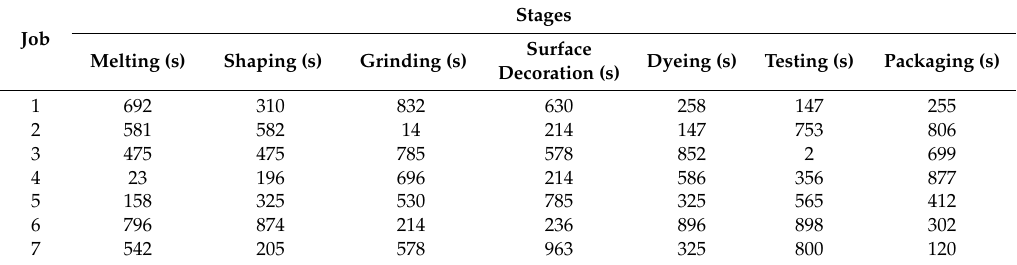
Table 1. Processing time in the permutation flow shop problem